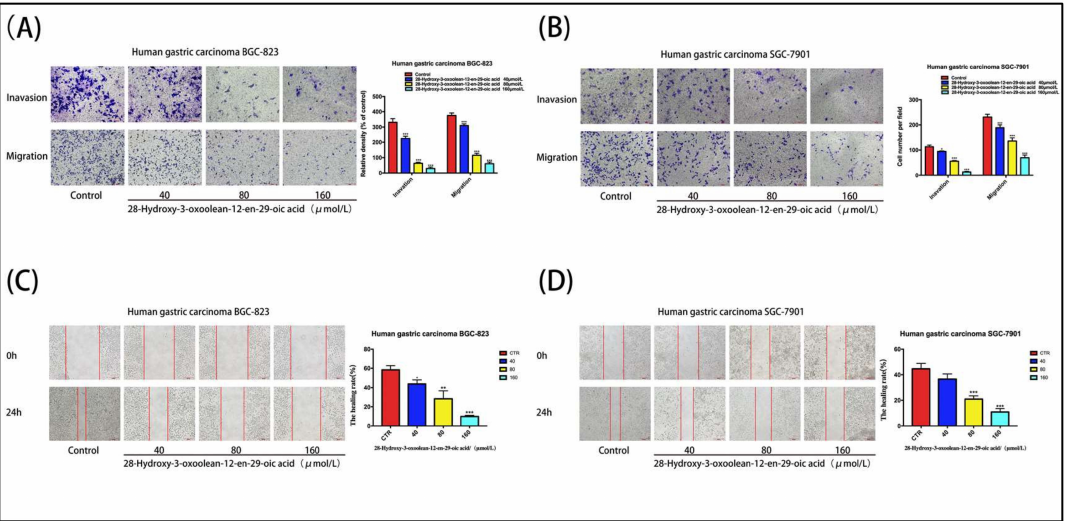
Figure 3. ( A ) Cell invasion assays were conducted using 24-well Transwell chambers with 8.0- µ m pore size polycarbonate membranes precoated with Matrigel. After treatment with various concentrations of 28-hydroxy-3-oxoolean-12-en-29-oic acid (40, 80 and 160 µ mol / L) for 24 h, the invaded cells on the lower membrane surfaces were fixed and stained with 5% crystal violet solution. ( B ) Cell migration assays did not use Matrigel coating. Images of SGC-7901 and BGC-823 cells were acquired under a microscope at 200 × magnification. ( C , D ) 28-Hydroxy-3-oxoolean-12-en-29-oic acid treatment for 24 h inhibited the migration of SGC-7901 cells and BGC-823 cells in a wound-healing assay in a dose-dependent manner. Images of SGC-7901 and BGC-823 cells were acquired under a microscope at 200 ×